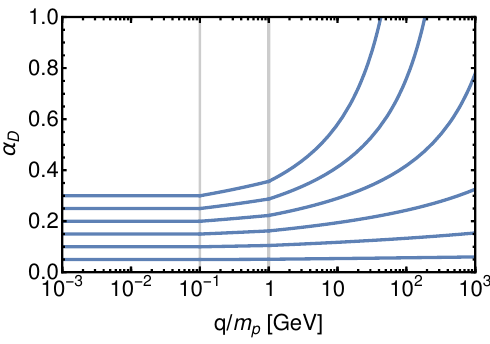
= m / 10. For α ( m ) (cid:174) 0.2 e p p D . The non- p = 0.68, indi- D , and D